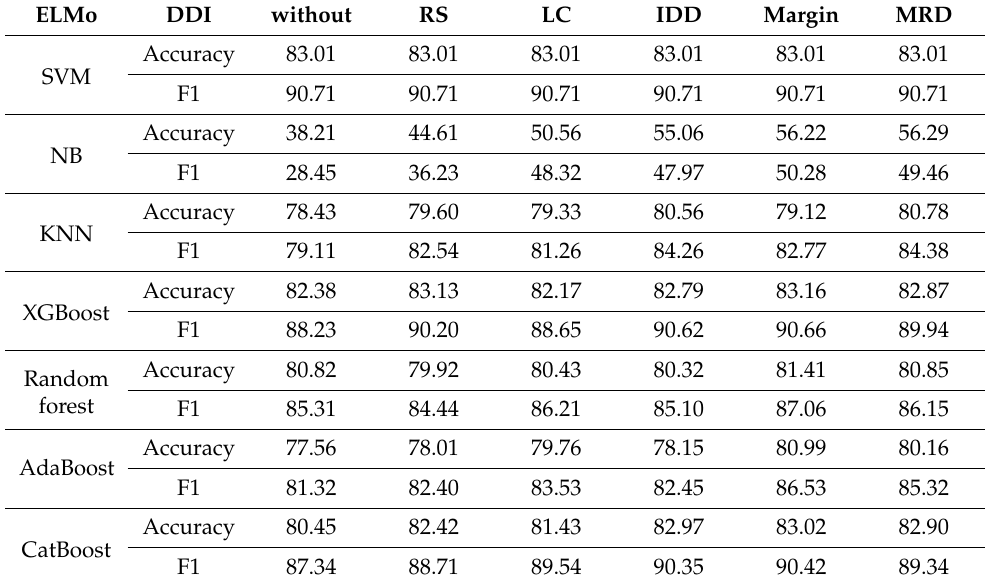
Table 11. Comparison of results with and without AL methods (ELMo) for DDI